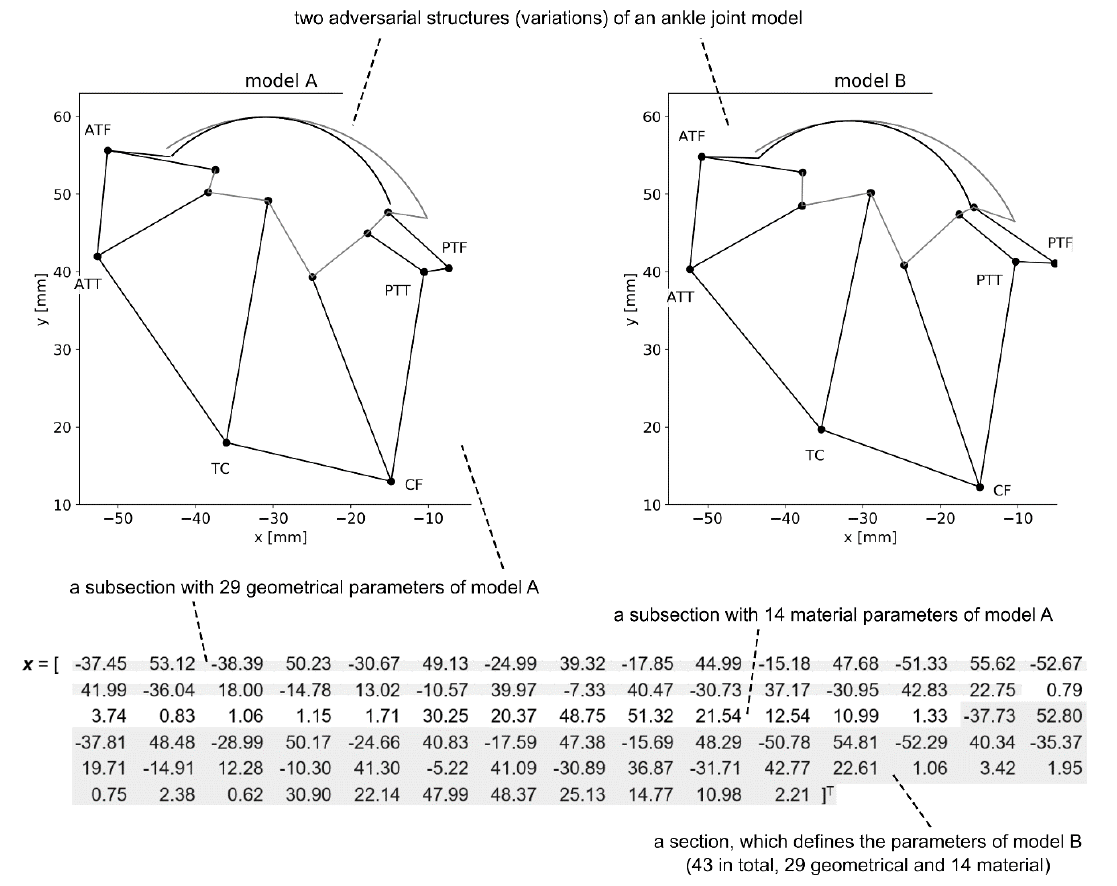
Figure 2. The proposed encoding of the adversarial structures—an example prepared based on an ankle joint model [26].